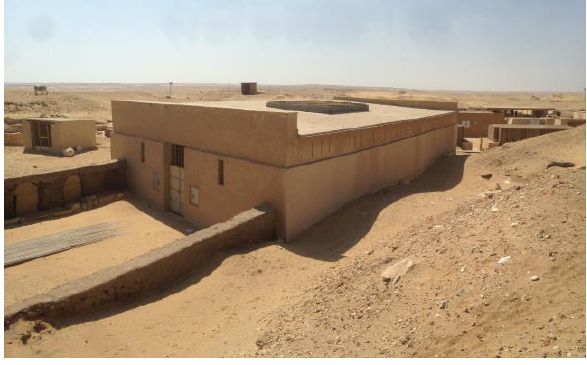
Figure 4. The tomb of Meryneith, encapsulated in a protective structure (photograph by L. Perfetti, 2019)